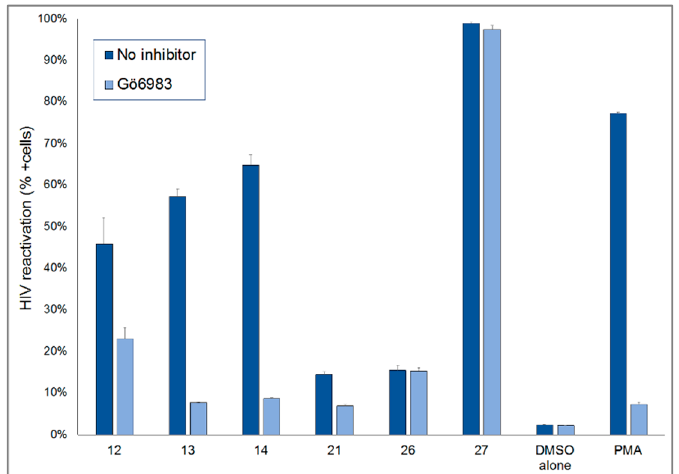
Figure 7. Effect of PKC inhibition on HIV-1 reactivation of compounds 13 – 14 , 21 , 26 , and 27 .